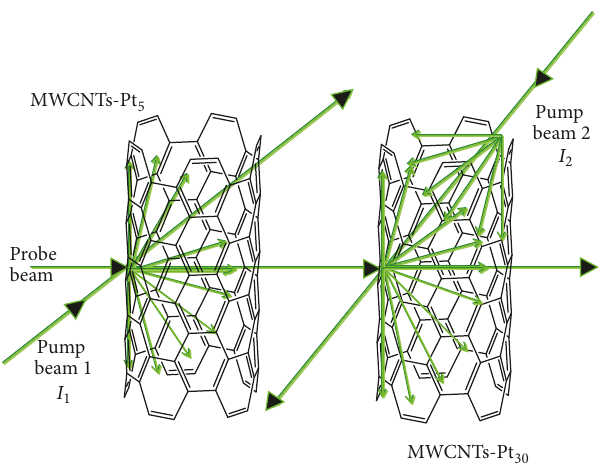
Figure 1: Experimental scheme of the double-stage